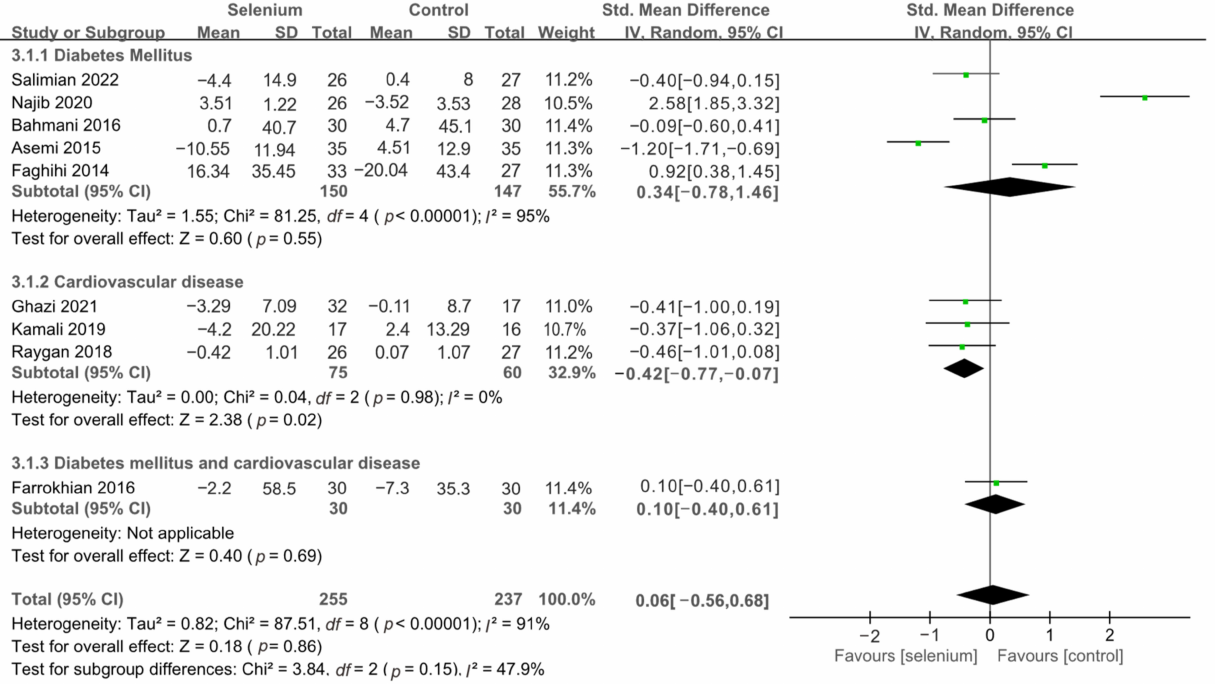
Figure 8. Subgroup analysis of FPG [30,41–48].